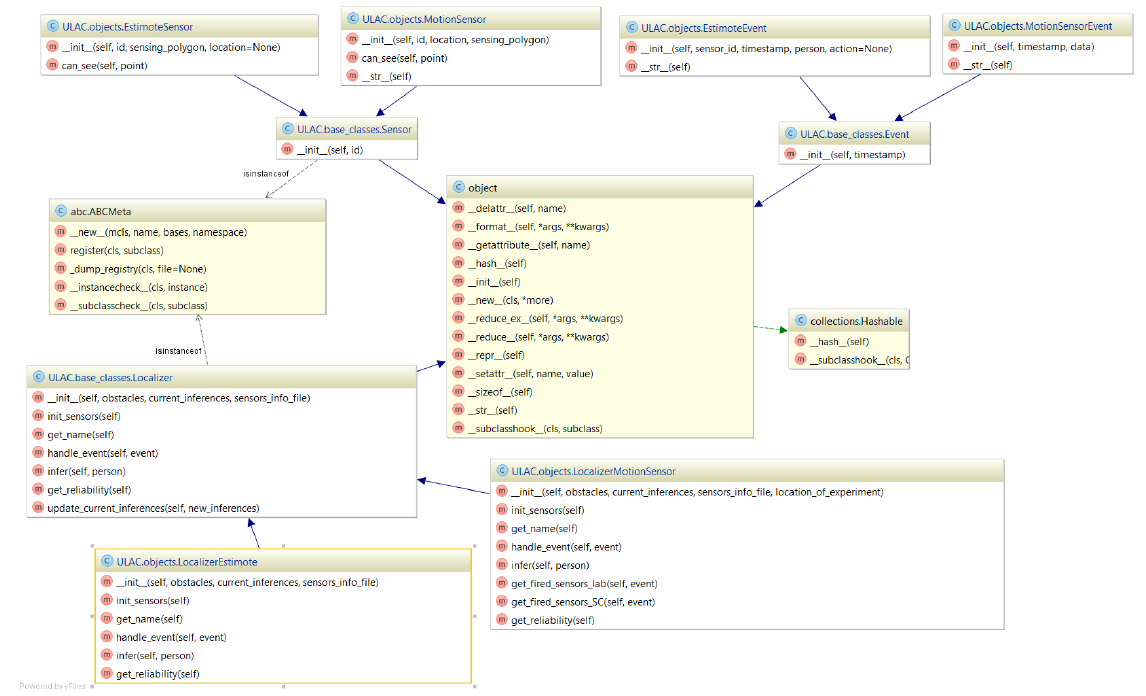
Figure 2. UML (Unified Modeling Language) diagram of the basic